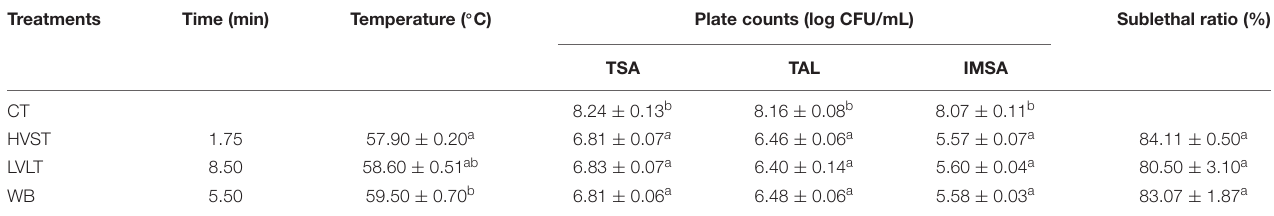
TABLE 1 | Inactivation of E. coli O157:H7 cells by HVST, LVLT, and WB treatments. Treatments Time (min) Temperature ( ◦